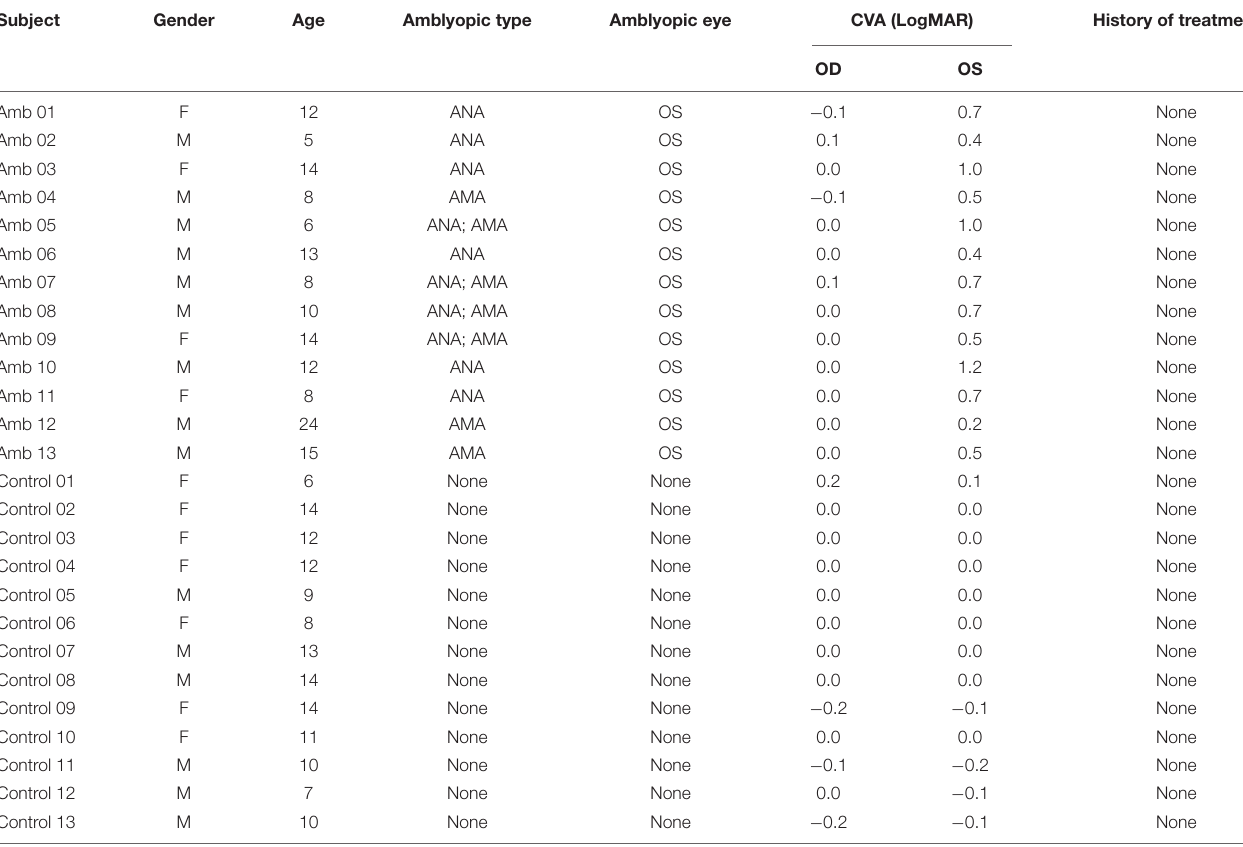
TABLE 1 | Demographic information of